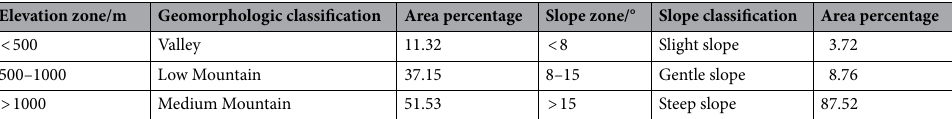
Table 1. Elevations, slope reclassifications, and land type classifications and their area percentages (%).